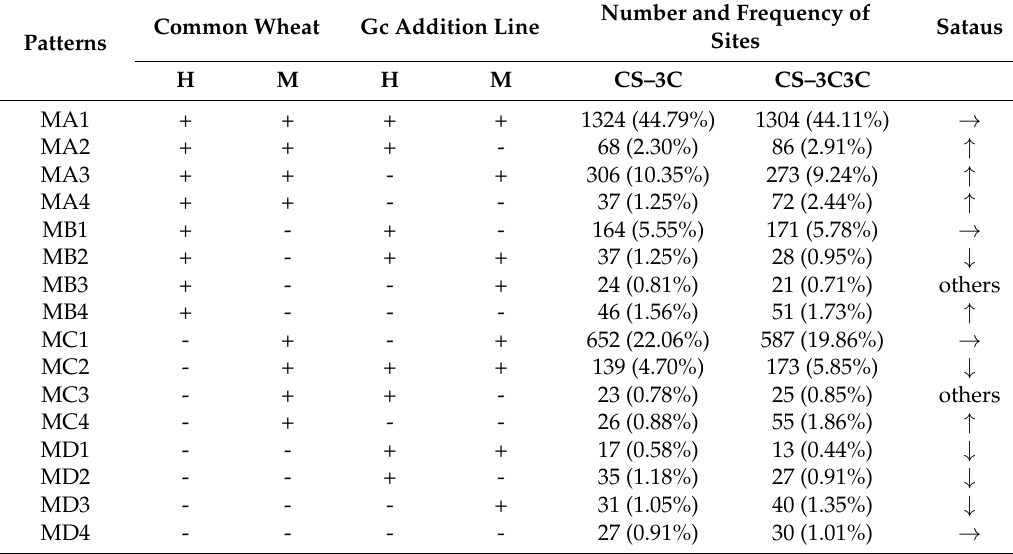
Table 3. Comparison of DNA methylation patterns between the CS–Gc addition lines and common wheat CS.